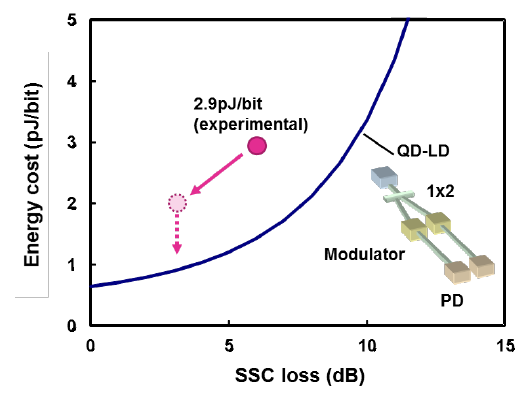
Figure 7. Energy cost estimation of a QD LD as a light source of a silicon